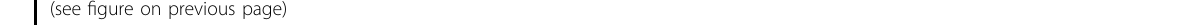
Fig. 8 Synergistic cancer therapeutics. a1 Schematic illustration of CSNT for imaging-guided RT/PTA synergistic therapy. a2 Temperature variation of CSNT solutions irradiated by a 980 nm NIR laser (1.5 W cm − 2 , 5 min). a3 The impact of CSNT on the X-ray radiation dose. a4 Viability of HeLa cells incubated with CSNTs at different concentrations with or without 980 nm laser irradiation and RT. a5 Viability of HeLa cells that have taken up CSNTs treated with RT, PTA, and RT/PTA. a6 Relative tumor growth curves of different groups. a7 Digital photographs of mice from group 7 after 30, 60, 90, and 120 days of treatment 22 . b1 Schematic illustration of UMNOCC-PEG for imaging-guided tumor therapy. b2 CLSM images of HeLa cells co-stained with calcein AM (live cells, green) and PI (dead cells, red) after different treatments (0.5 W cm − 2 , 500 μ g mL − 1 ). b3 Photographs of the representative mice and excised tumors 137 . c1 Schematic illustration of synergistic phototherapy to enhance antitumor immunity. Tumor growth curve ( c2 ), tumor weight ( c3 ), and representative H&E staining ( c4 ) of 4T1 tumor-bearing mice after different treatments. Detection of DC maturity (CD80 + CD86 + gated on CD11c + ) in tumor-draining lymph nodes ( c5 ) and CTLs (CD4 − CD8 + gated on CD3 + ) in the spleen ( c6 ) by fl ow cytometry. Mean tumor growth kinetics ( c7 ) and corresponding survival rates ( c8 ) of mice after different treatments 139 . a1 – a7 Reprinted with permission from ref.